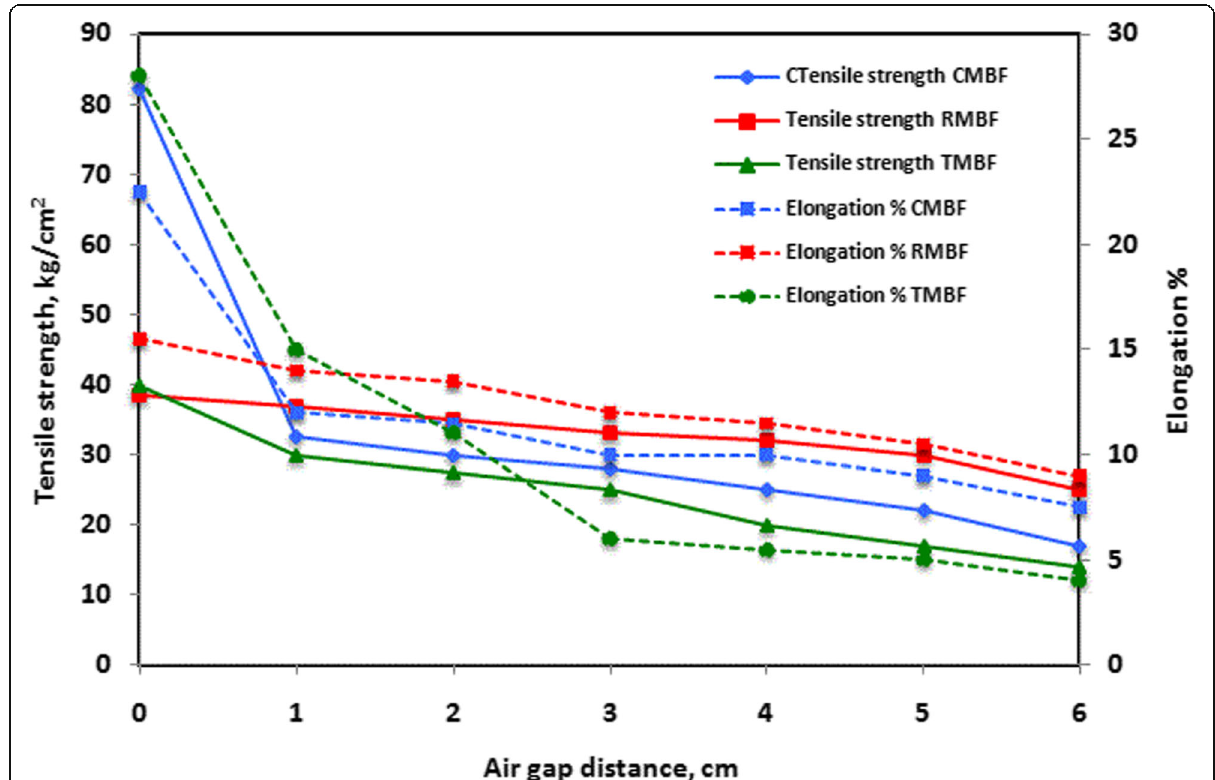
Fig. 16 Effect of air gap distance on the tensile strength and elongation % at different configurations